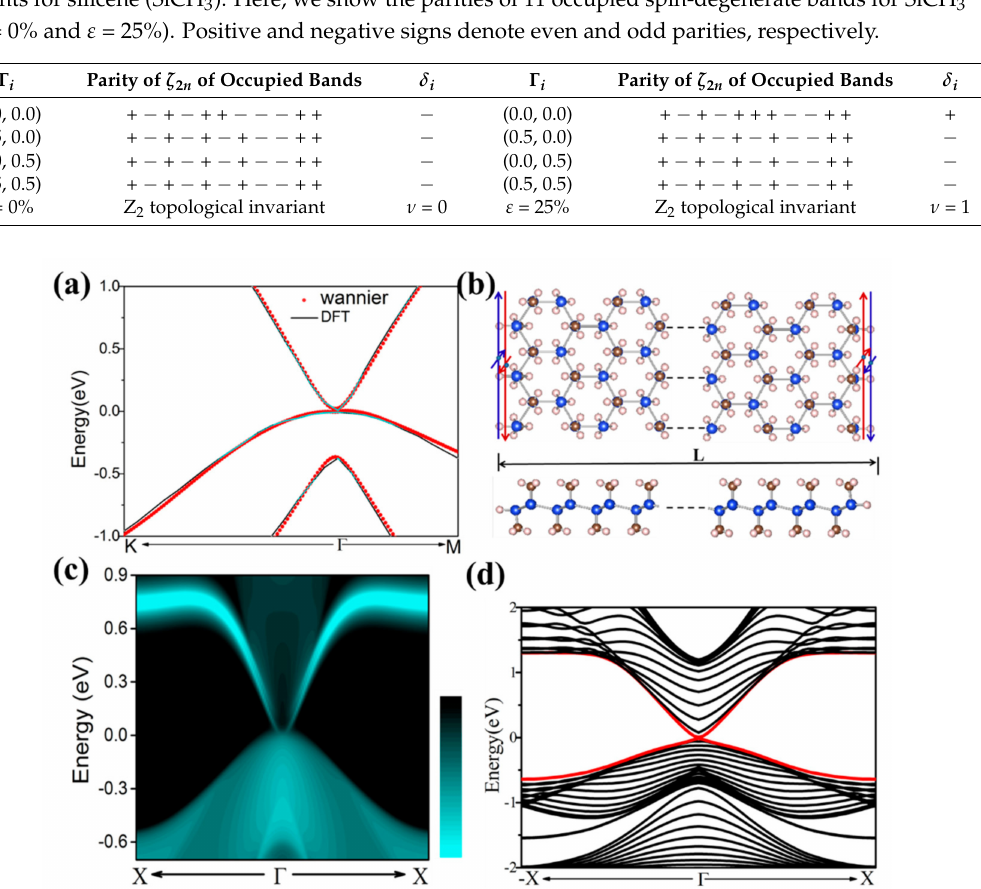
Figure 5. Electronic structure and its corresponding edge state of SiCH 3 with 25% tensile biaxial strain. ( a ) Comparison of band structures for SiC density functional theory (DFT) H 3 , calculated by DFT (red lines) and Wannier functions method (blue dots); ( c ) Show the Dirac edge states. The Fermi level is set to zero; ( b , d ) the model and spectrum of a finite slab of SiCH 3 . The red and black horizontal arrows represent the spin-up and spin-down polarized currents in the opposite